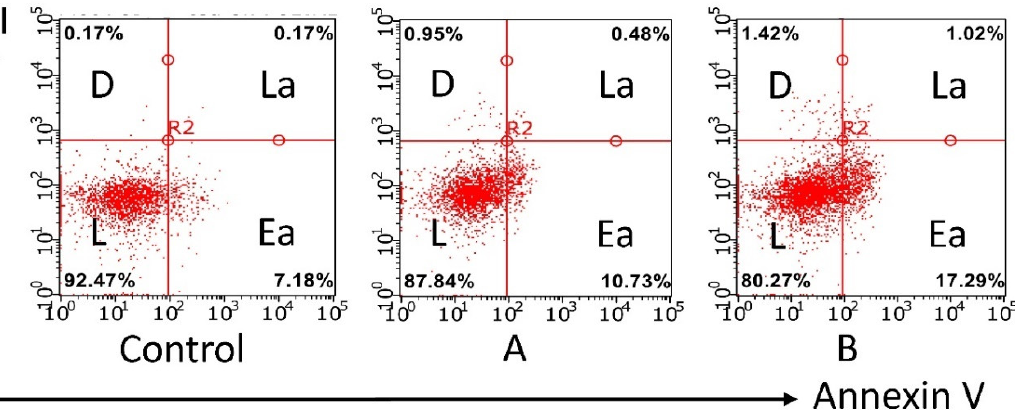
Figure 7. Apoptotic effects of 3f on M-HeLa cells. ( A ) M-HeLa cells were treated with the indicated compound 3f at a concentration of 50 µ M. ( B ) M-HeLa cells were treated with the indicated compound 3f at a concentration of 100 µ M. The values are presented as the mean ± SD ( n = 3). L—living cells; D—dead cells; Ea—early apoptotic cells; La—late apoptotic cells.